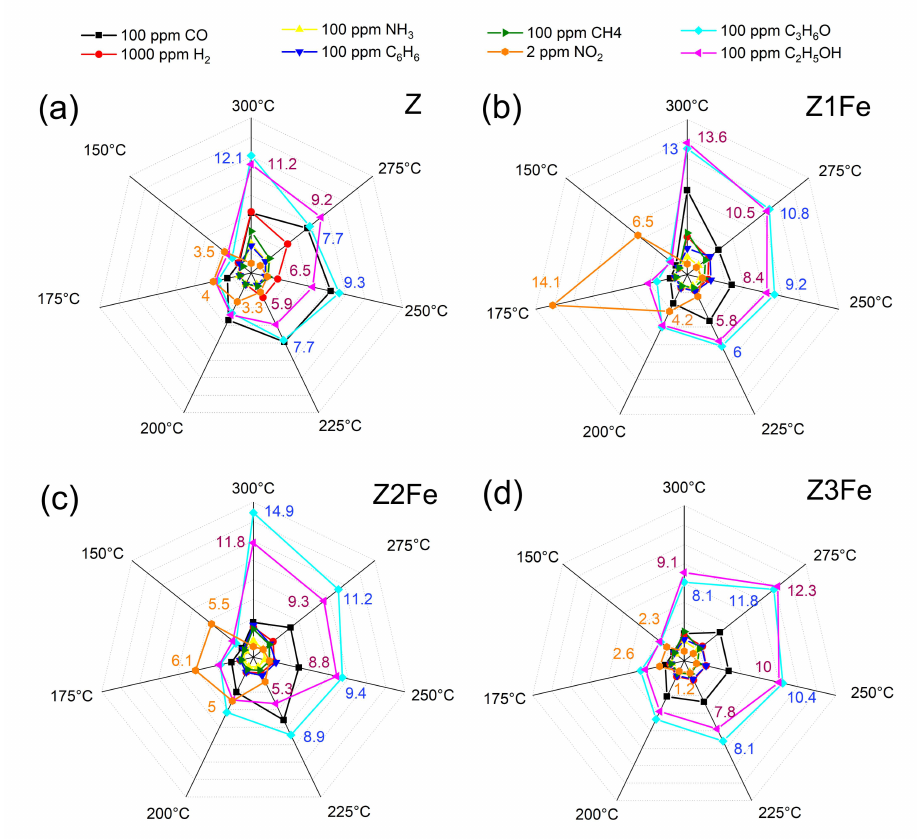
Figure 8. Selectivity diagrams responses to various gases (H 2 , CH 4 , CO, C 6 H 6 , NH 3 , ethanol, acetone, and NO 2 ) at 150–300 ◦ C of the samples: ( a ) Z, ( b ) Z1Fe, ( c ) Z2Fe, and ( d )